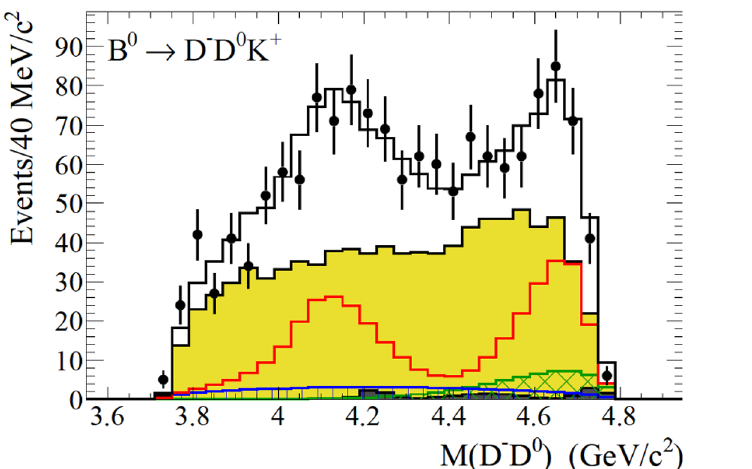
Figure 4 . The invariant mass distribution of D 0 D − in the decay B 0 → D 0 D − K + in the Babar [14] data. The dots show the data, the histograms show the resulting description by the model and individual